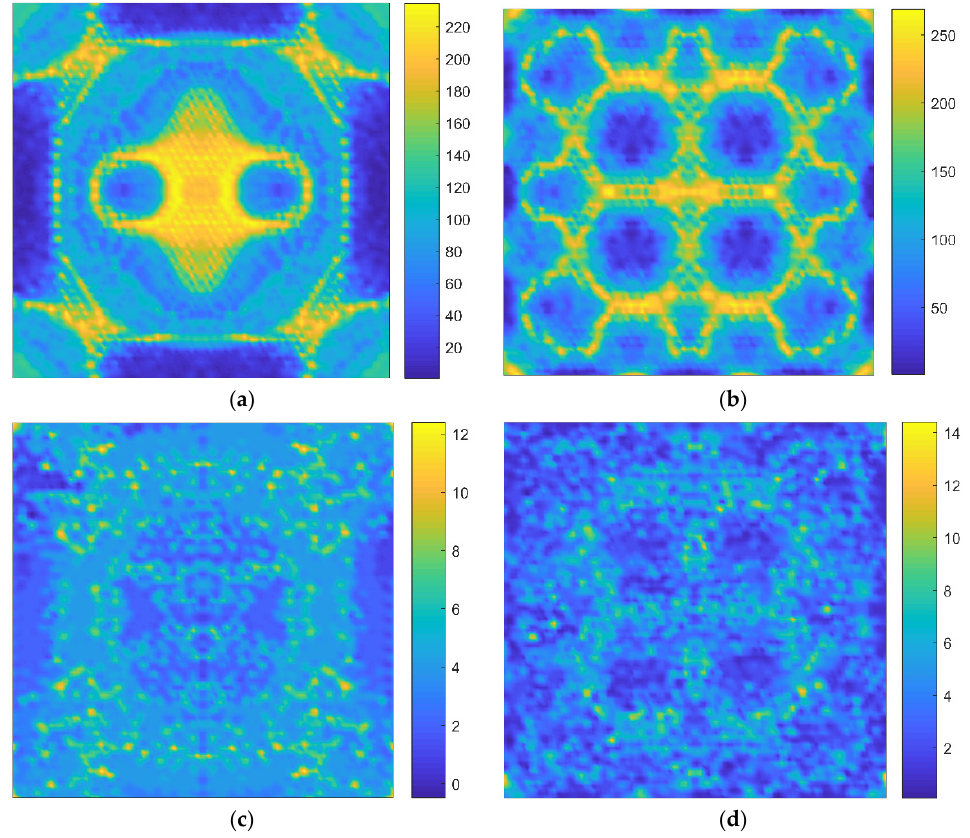
Figure 7. The comparison for number distributions of indistinguishable atoms (( a , b ) represent the 1st and 10th resonant vibration modes with limitation at 10 − 5 , while ( c , d ) represent those at 10 − 7 , respectively).